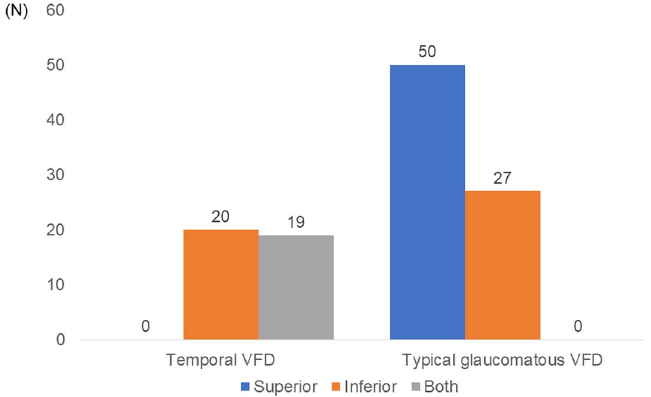
Figure 1. Location of Visual Field Defect in All eyes (N, 74). Distributions of visual field defect in each hemisphere are shown. (chi-squared test, P < 0.001). VFD visual field defect.